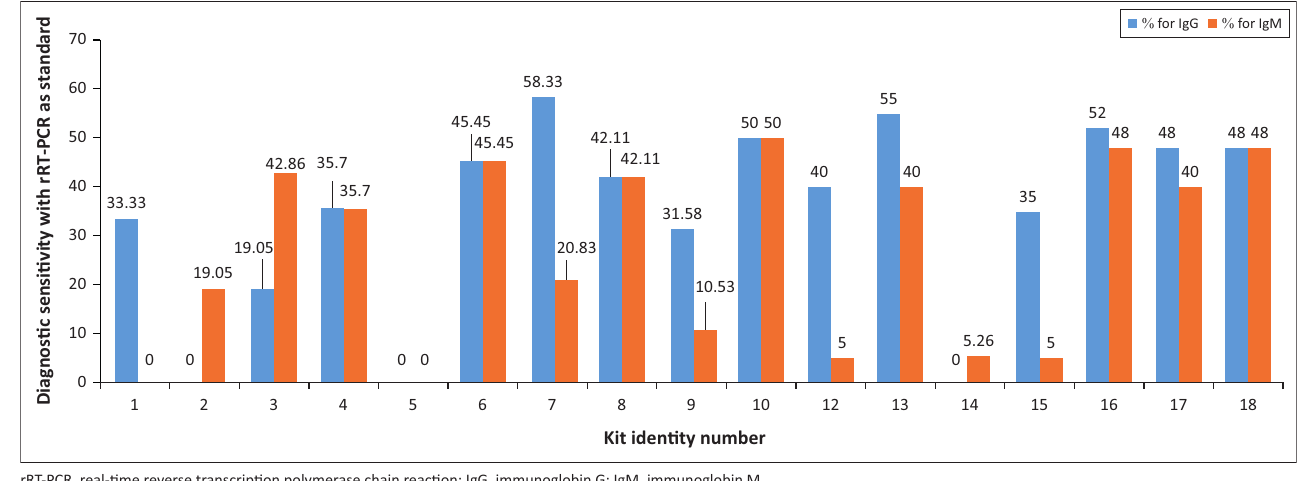
FIGURE 2: Diagnostic sensitivity of the pre-assessed COVID-19 point-of-care tests submitted to the Kenya Medical Research Institute by the Pharmacy and Poisons Board, Nairobi, Kenya, for pre-evaluation assessment, March 2020 – May 2020. Separate IgG or IgM sensitivities were assessed using rRT-PCR as standard.